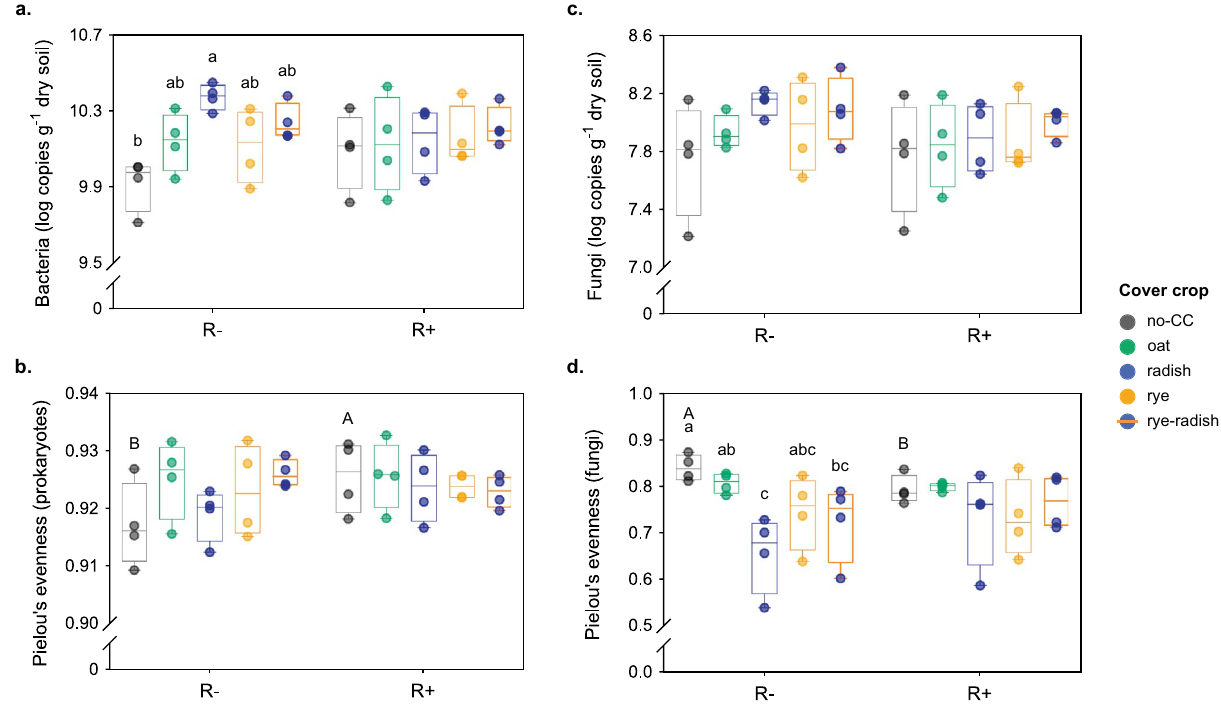
Figure 1. Microbial community structure in soils under different CCs and residue management: ( a , c ) Bacterial and fungal abundance, respectively; ( b , d ) Prokaryotic and fungal ASV evenness (Pielou’s index), respectively. Colors indicate different CCs and R+/R− refers to main crop residues present or absent, respectively. Different lowercase letters show significant differences between CCs within residue treatments, while different uppercase letters show differences between residue treatments (Tukey test, alpha = 0.05). Letters are only shown for comparisons with P < 0.05. R−/R+ refers to main crop residues absent or present,